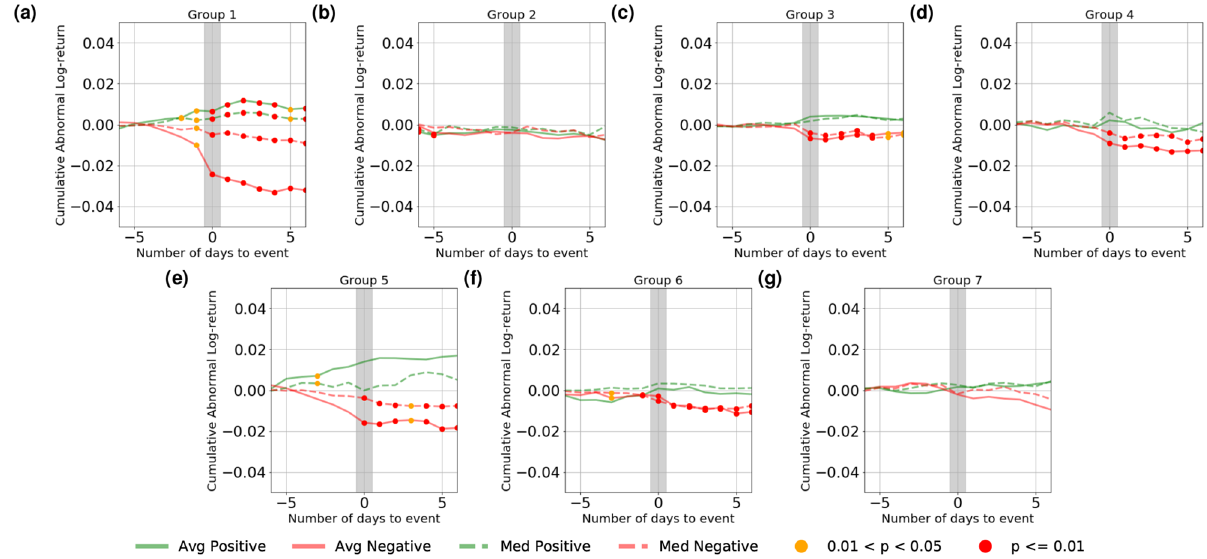
Figure 3. Change in mean and median CAR of the companies experiencing sentiment events, computed over all events over the time period and averaged over each company